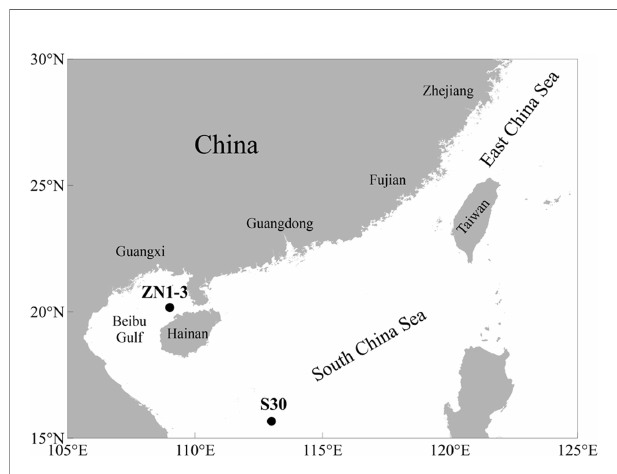
FIGURE 1 | Sampling sites (S30 and ZN1-3) in the South